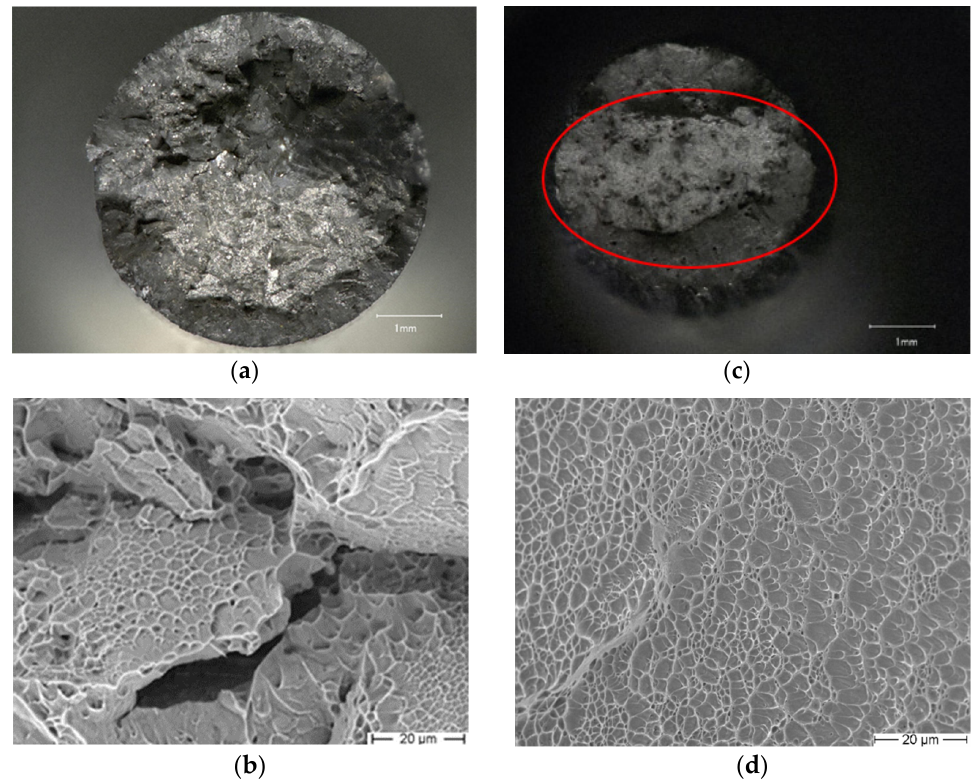
Figure 9. Different fracture surfaces of an EB-PBF-manufactured Ti-5553 alloy using E L = 600 J/m. ( a , b ): STA; ( c , d ): BASCA. ( a ) as well as ( c ) are overviews and ( b , d ) are close ups.